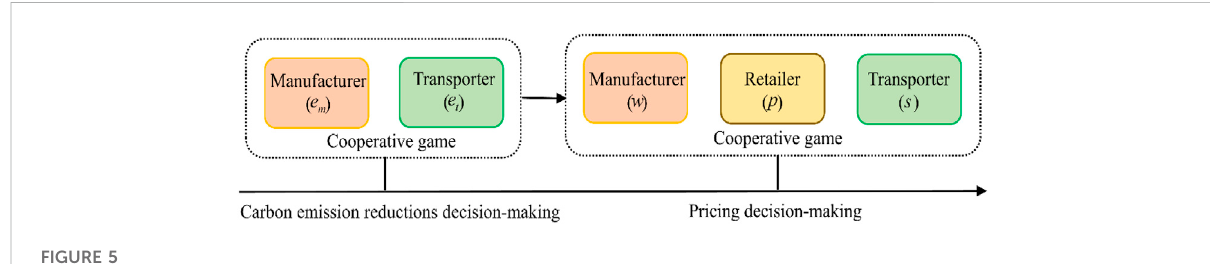
FIGURE 5 The order of decision-making and the game types of supply chain members for the CC